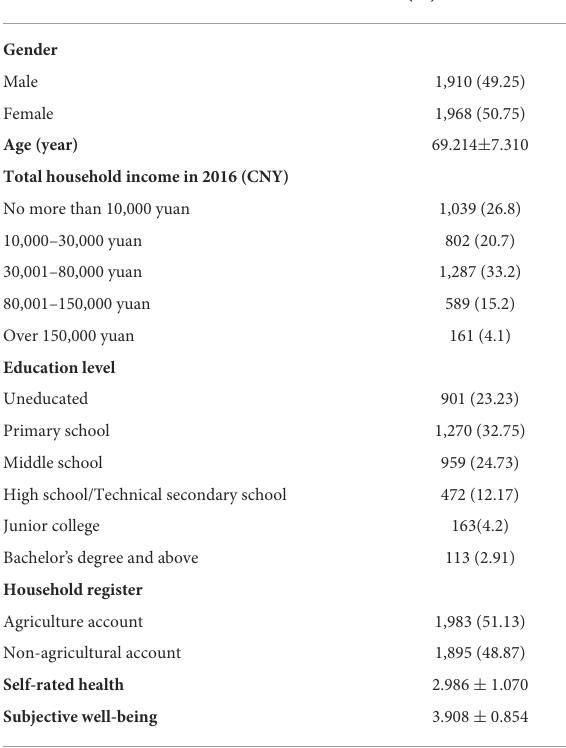
TABLE 1 Sociodemographic information of the participants ( N =